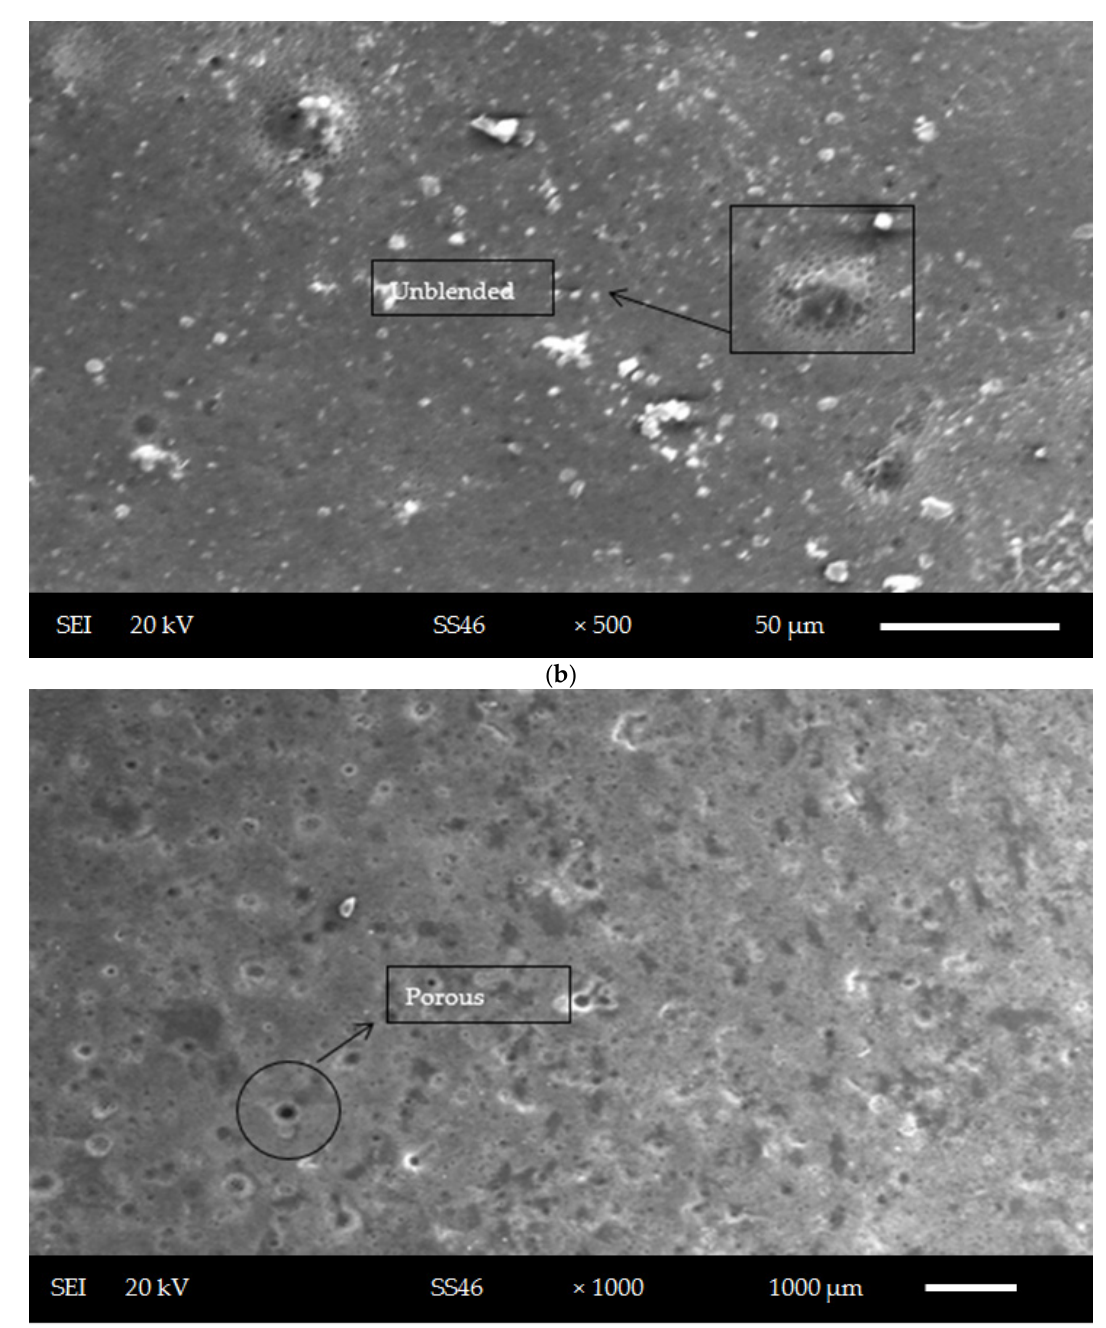
Figure 1. Analysis result on the PLA variations of ( a ) biofilm 1, ( b ) 3 biofilm 2, and ( c ) biofilm 3 to observe the blendable properties between matrix (PLA) and filler (chitosan–TEO) .